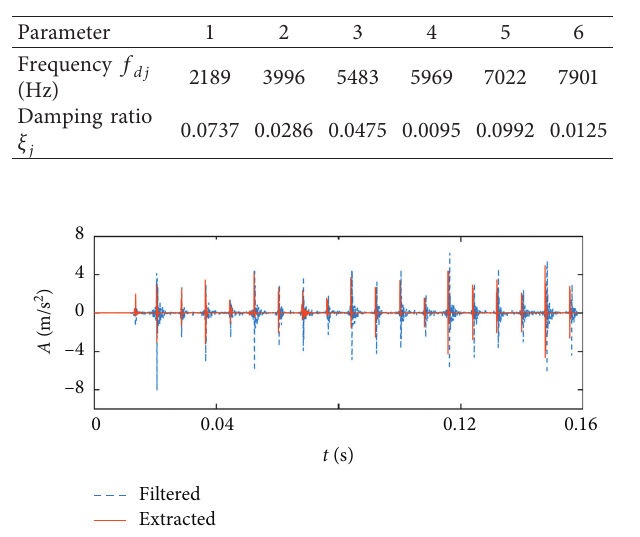
Figure 5: Filtered noiseless signal and extracted feature signal under the noiseless